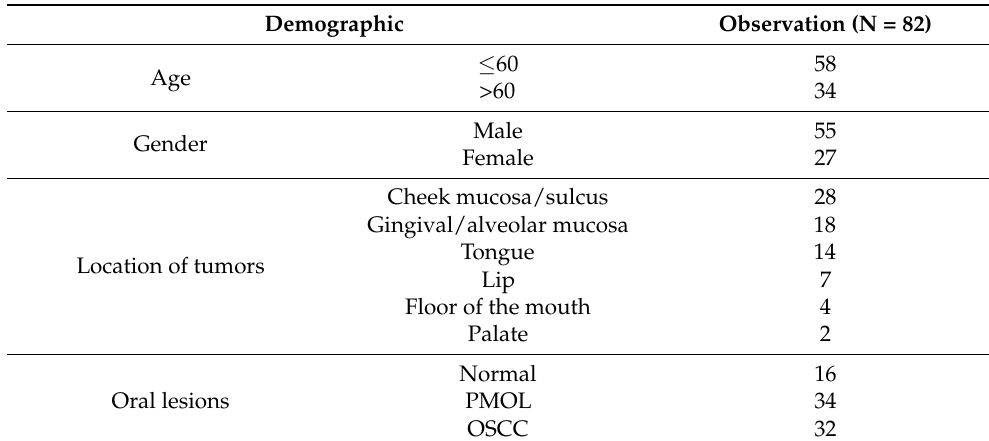
Table 3. Demographic parameters and their